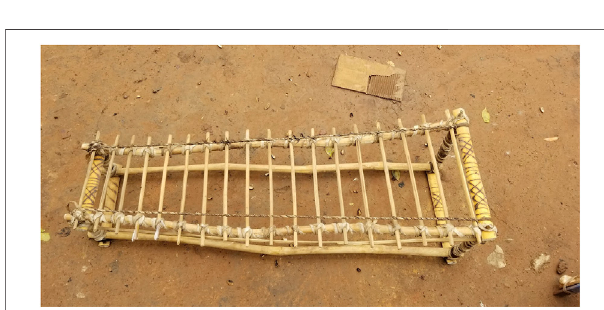
FIGURE 2 | Balafon frame.